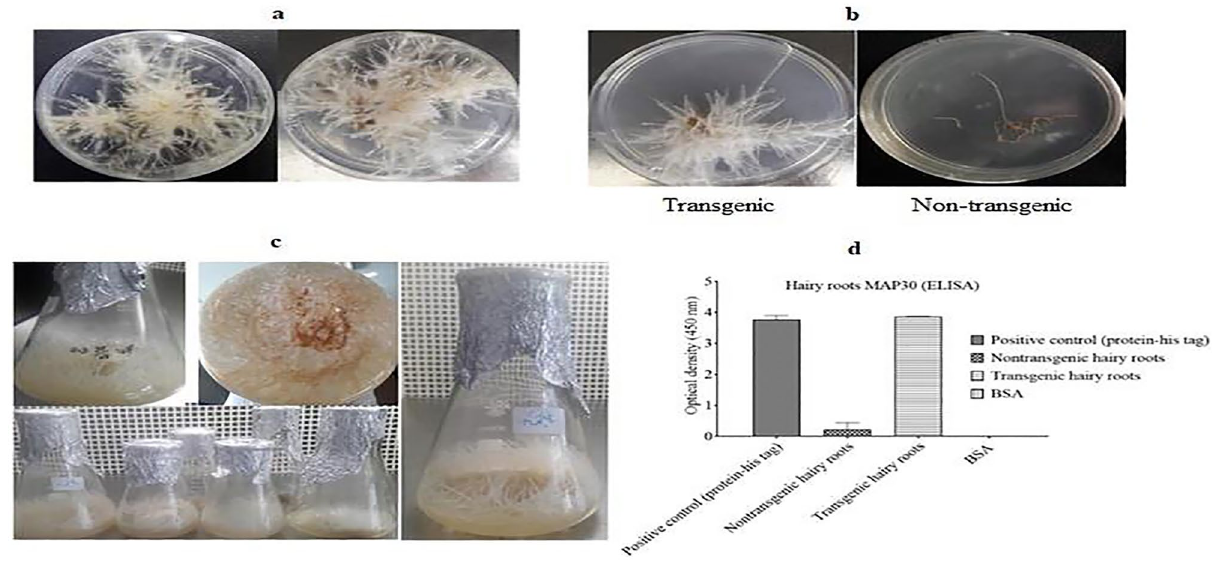
Figure 2. Formation and elongation of N. tobacco hairy roots at different periods after the A. rhizogenes infection. ( a ) The emergence of transgenic hairy roots from bacterial inoculated leaf explants grown on a solid MS medium with 30 mg/L of meropenem and 100 mg/L of kanamycin, which had been maintained at 25 °C under a 16/8 h light/dark photoperiod for 2 weeks after the infection; ( b ) the growth pattern of non-transgenic hairy root samples on kanamycin, and non-kanamycin culture media. The inability to grow on a medium that contains kanamycin and meropenem, and the growth process on an environment that only